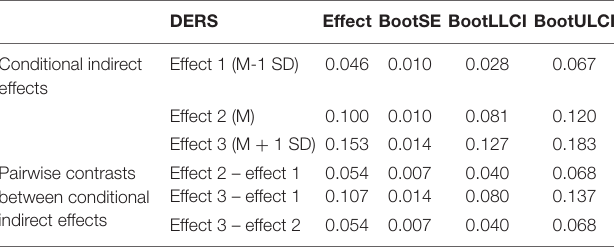
TABLE 5 | Conditional indirect effects of CTQ on BDI under different levels of DERS and pairwise contrasts between conditional indirect effects. DERS Effect BootSE BootLLCI